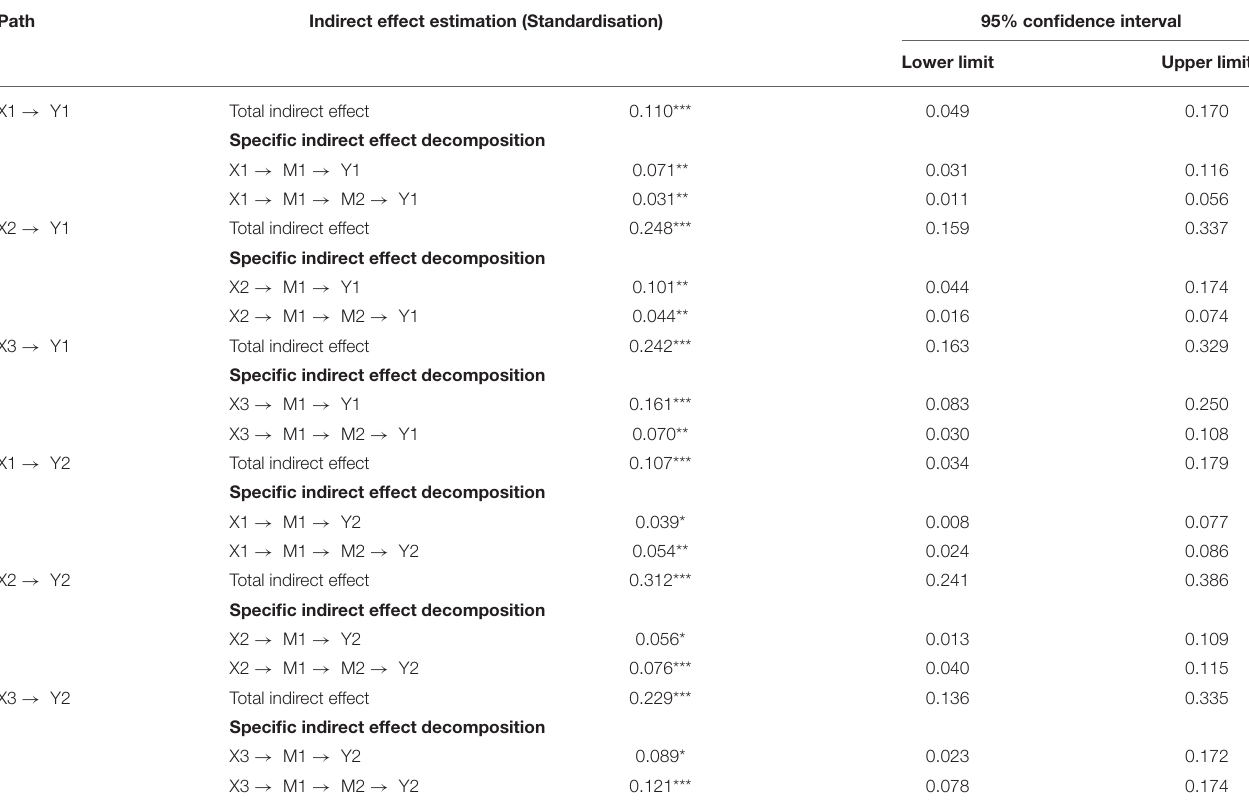
TABLE 3 | Testing the mediating